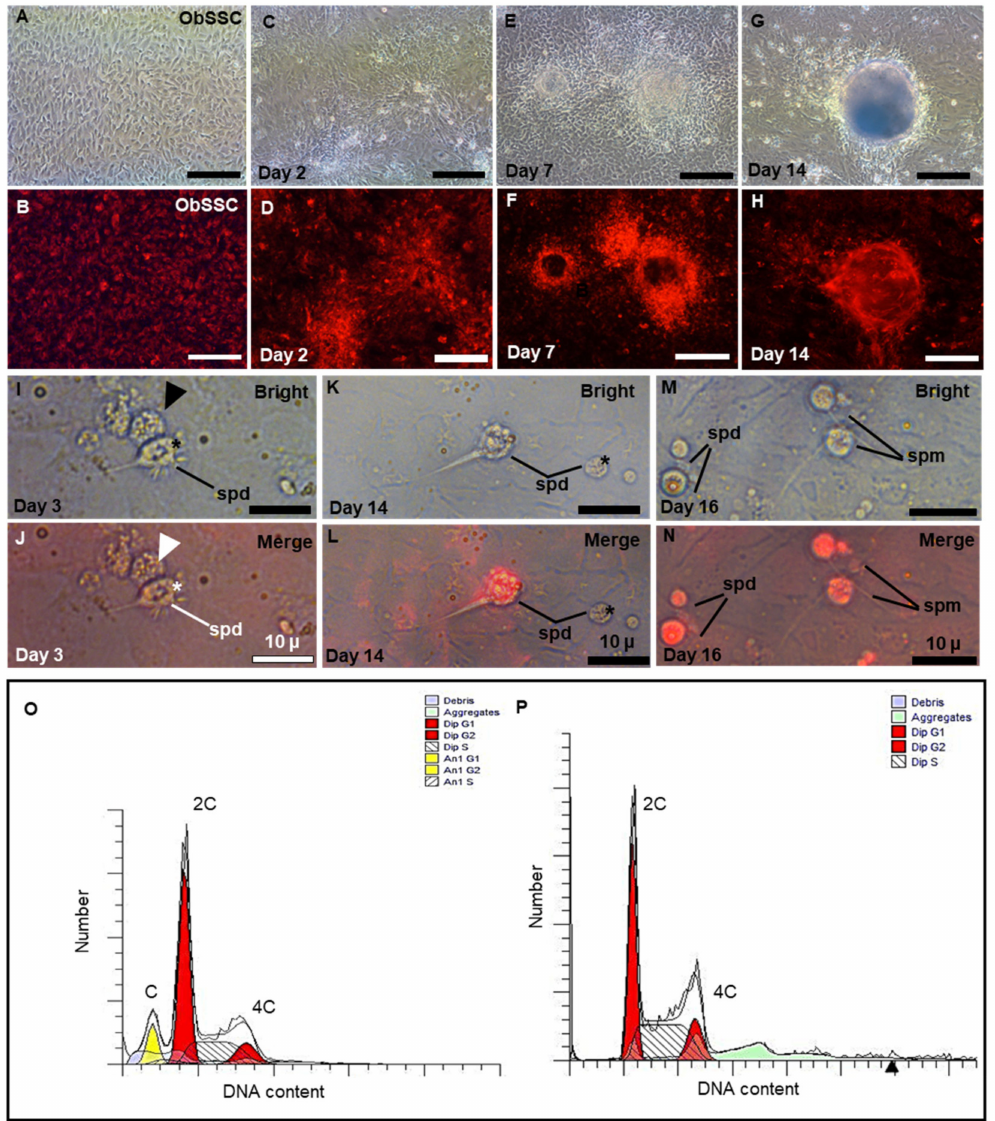
Figure 6. Sperm production of ObSSCs in vivo. ( A , B ) The RFP-expressing ObSSCs were evenly distributed in the culture wells. ( C – H ) Coculture of O. bidens primary testicular cells and ObSSCs at Passage 70 were maintained at confluence without subculture for 2 weeks. ( I – N ) After coculture of O. bidens primary testicular cells and ObSSCs, sperm production can be observed in the culture medium. ( I , J ) Sperm from O. bidens primary testis cells. A cluster of four sperm from a tetrad is indicated by an arrow. ( K – N ) RFP-positive, spermatid, and sperm with a thin and long tail. ( O ) Primary testicular cells showing a prominent haploid peak in addition to diploid and tetraploid peaks. ( P ) ObSSCs at Passage 70 were maintained under normal culture conditions for undifferentiated proliferation, showing diploid and tetraploid peaks. c, 2c, and 4c, haploid, diploid, and tetraploid DNA contents, respectively. (Scale bars, 100 µ m in ( A – H ); 10 µ m in ( I – N )). From Day 1 of coculture, we exposed cells to the EMS4 medium containing fetal bovine serum (FBS), basic fibroblast growth factor (bFGF), fish serum, and medaka embryo extract (MEM). It can be observed that RFP-expressing ObSSCs that grow uniformly before coculture are clustered under coculture with ObCTs (Figure 6A–D). After one week, ObSSCs and ObCT together formed EBs (Figure 6E–H). The volume of the EB increased after two weeks and did not increase significantly in the third week (Figure